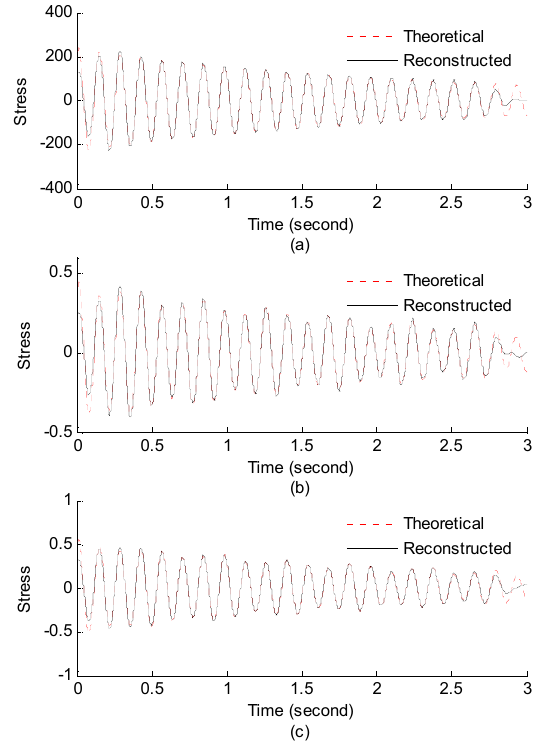
Figure 11. Reconstructed and theoretical bending stress responses for ( a ) the location I 1 ; ( b ) the location I 2 ; ( c ) the location I 3 .